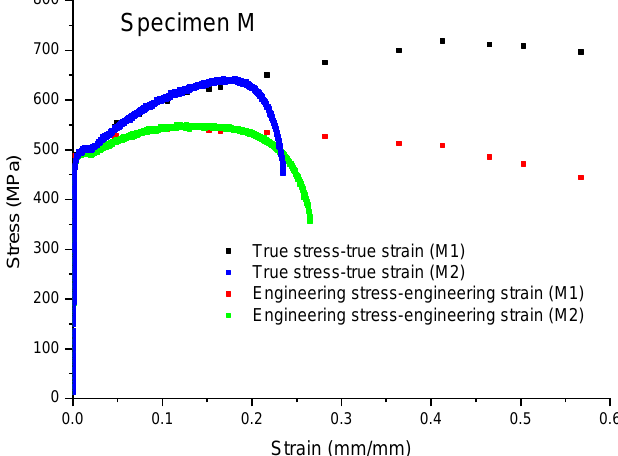
Figure 7. Comparison of the test results of specimens M1 and M2.